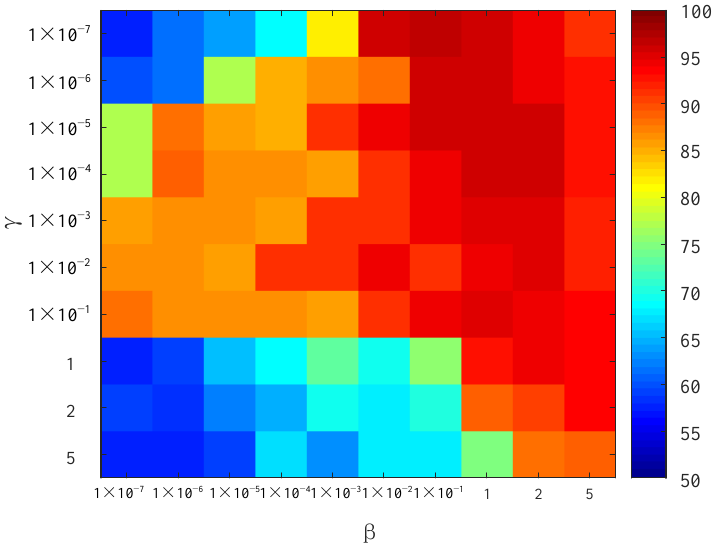
Figure 11. The recognition accuracy of different γ and β .